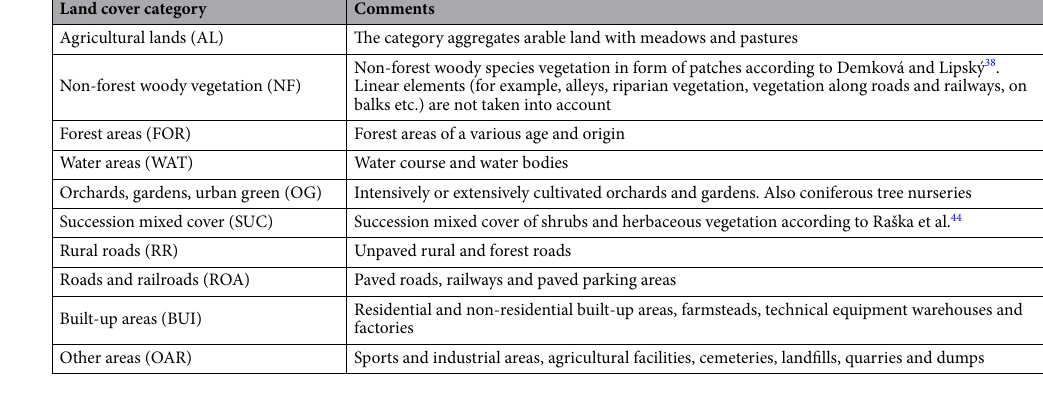
Table 1. Land cover classification categories with codes used in change trajectories